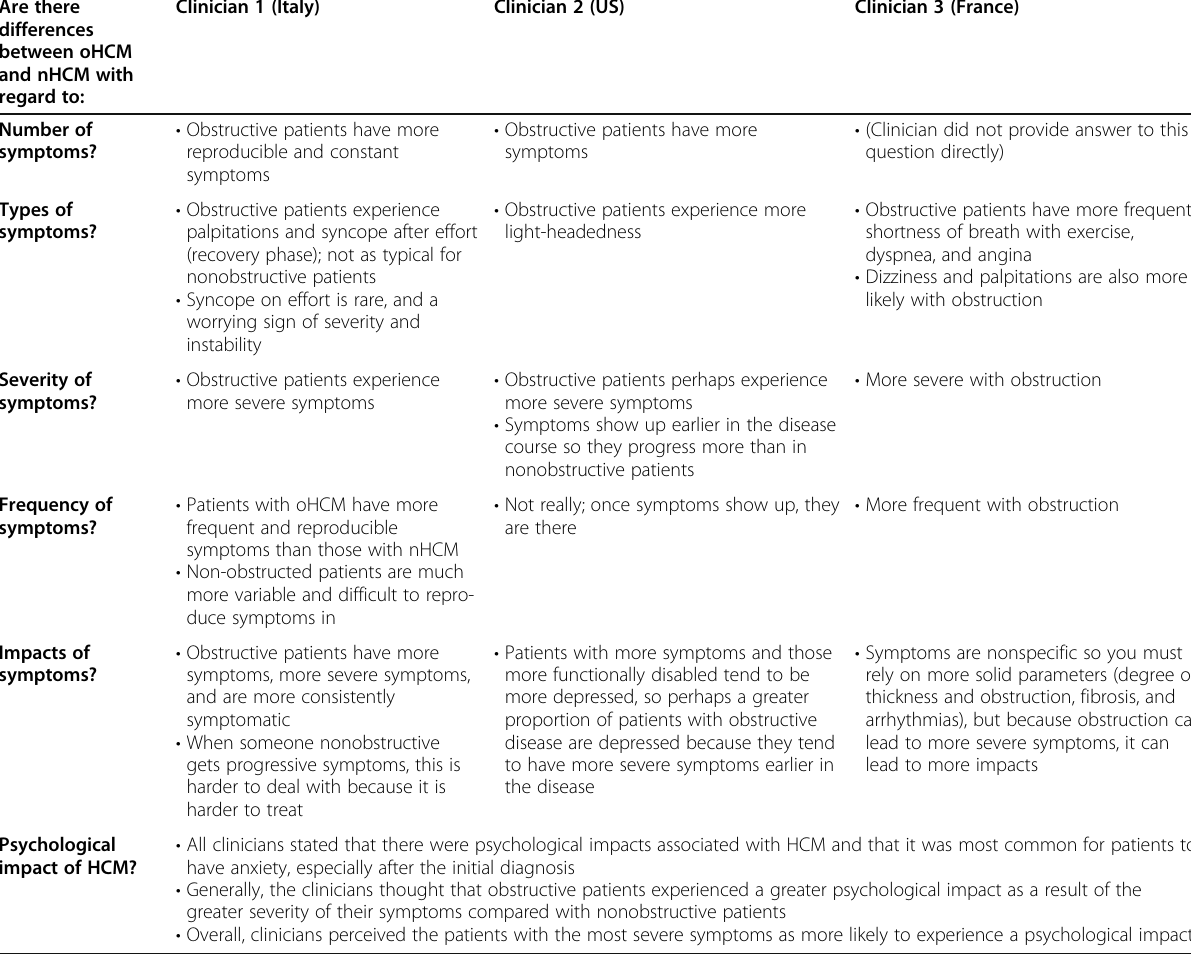
Table 1 Clinical similarities and differences between oHCM and nHCM as reported by clinical experts Are there differences regard